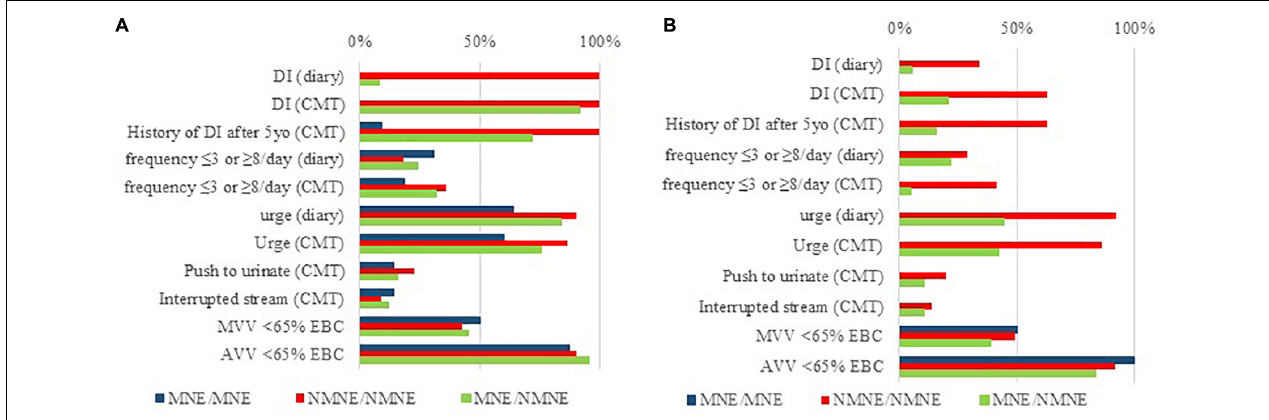
FIGURE 1 | Prevalence of LUTS and small voided volumes when subtyping enuresis with regards to the old (A) and new (B) ICCS definition for NMNE, in the three studied clinical groups (MNE/MNE, NMNE/NMNE, and MNE/NMNE). Considering the new ICCS definition, it is urgency rather than actual daytime urine loss that leads to an NMNE diagnosis. Moreover, small voided volumes (MVV < 65% of EBC and AVV < 65% EBC) are equally present in MNE and NMNE patients, regardless of the ICCS definition used.